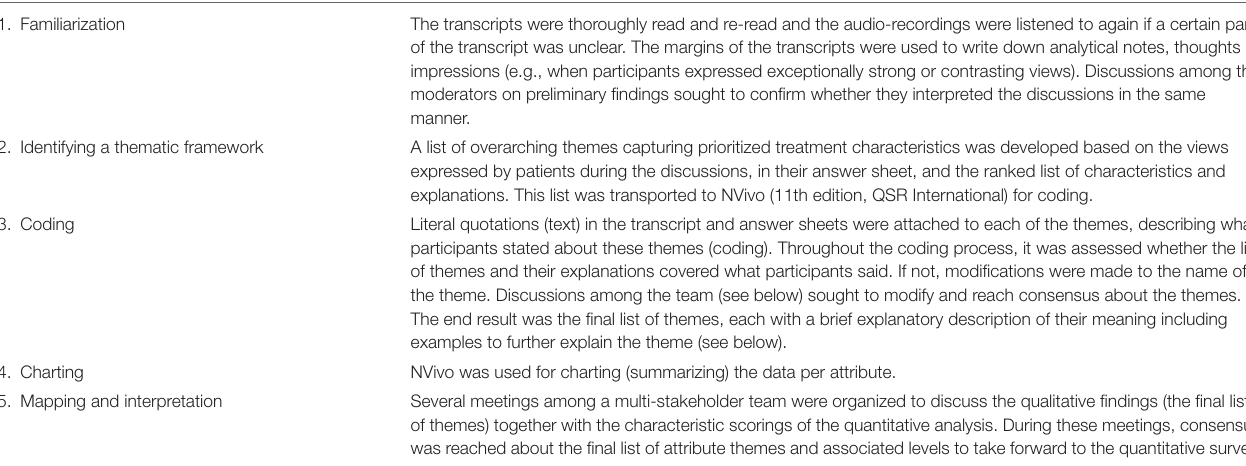
TABLE 1 | Iterative steps of the qualitative thematic analysis using the framework